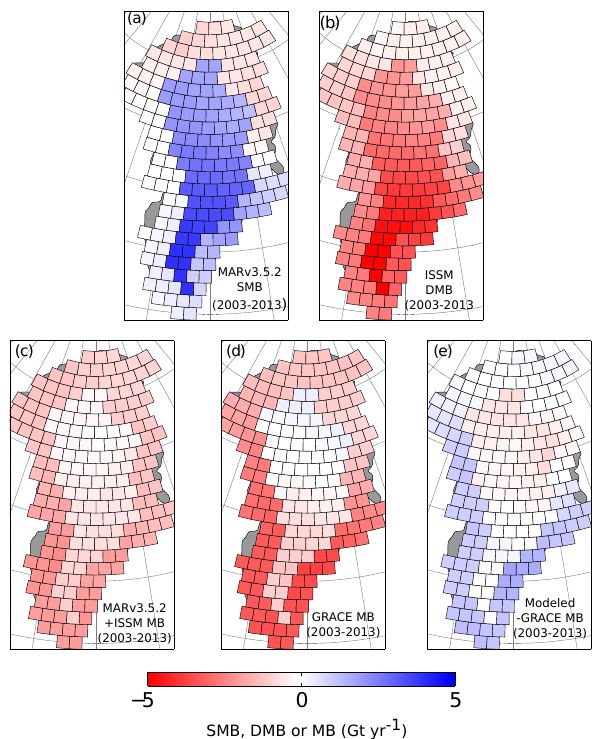
Figure 7. Average January 2003–December 2012 mass balance (Gt) for MAR, ISSM, and GRACE-LM. Gaussian spatial and temporal filtering have been applied to MAR and ISSM outputs. (a) SMB from MAR, (b) dynamic mass change from ISSM, (c) the sum of (a) and (b) , giving the mean MB. GRACE-LM mean MB is shown in (d) , and (e) depicts the difference between modeled MB (c) and GRACE-LM MB (d)